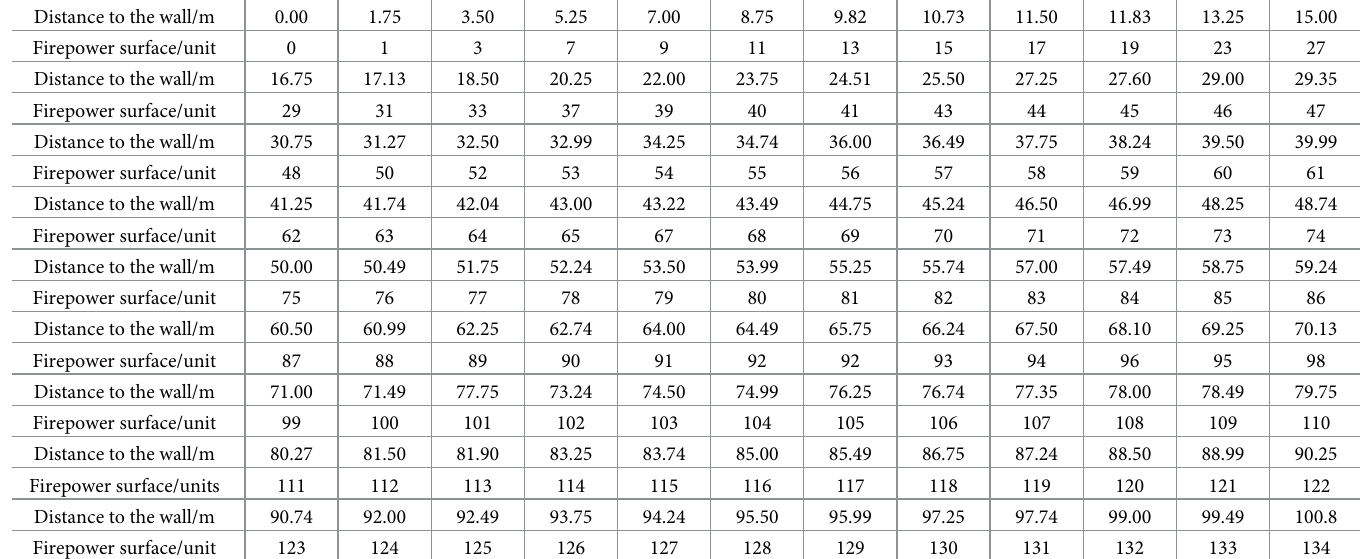
Table 3. Calculation of the firepower value of the space under the east wall of Puzhuang Suo-Fort. Distance to the